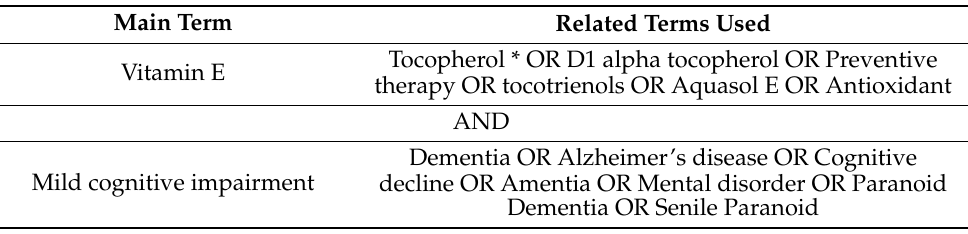
Table 1. List of keywords used for literature